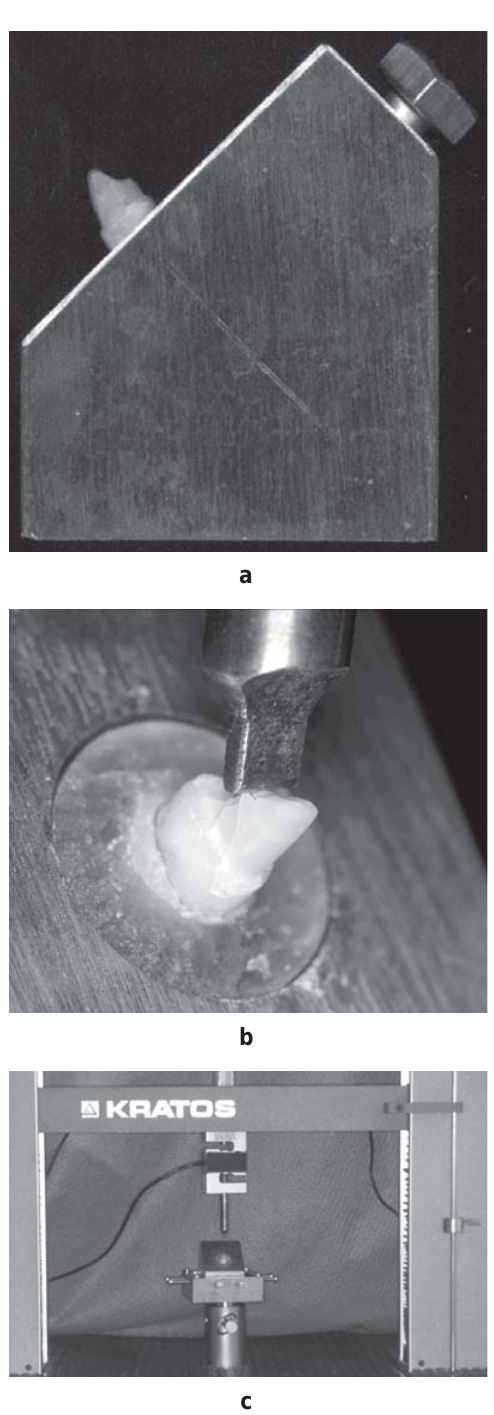
FIGURE 2- Scheme of load application at an angle of 45° a) 135.4° angle formed by contact between the maxillary and mandibular central incisors in a Class I occlusal relationship;